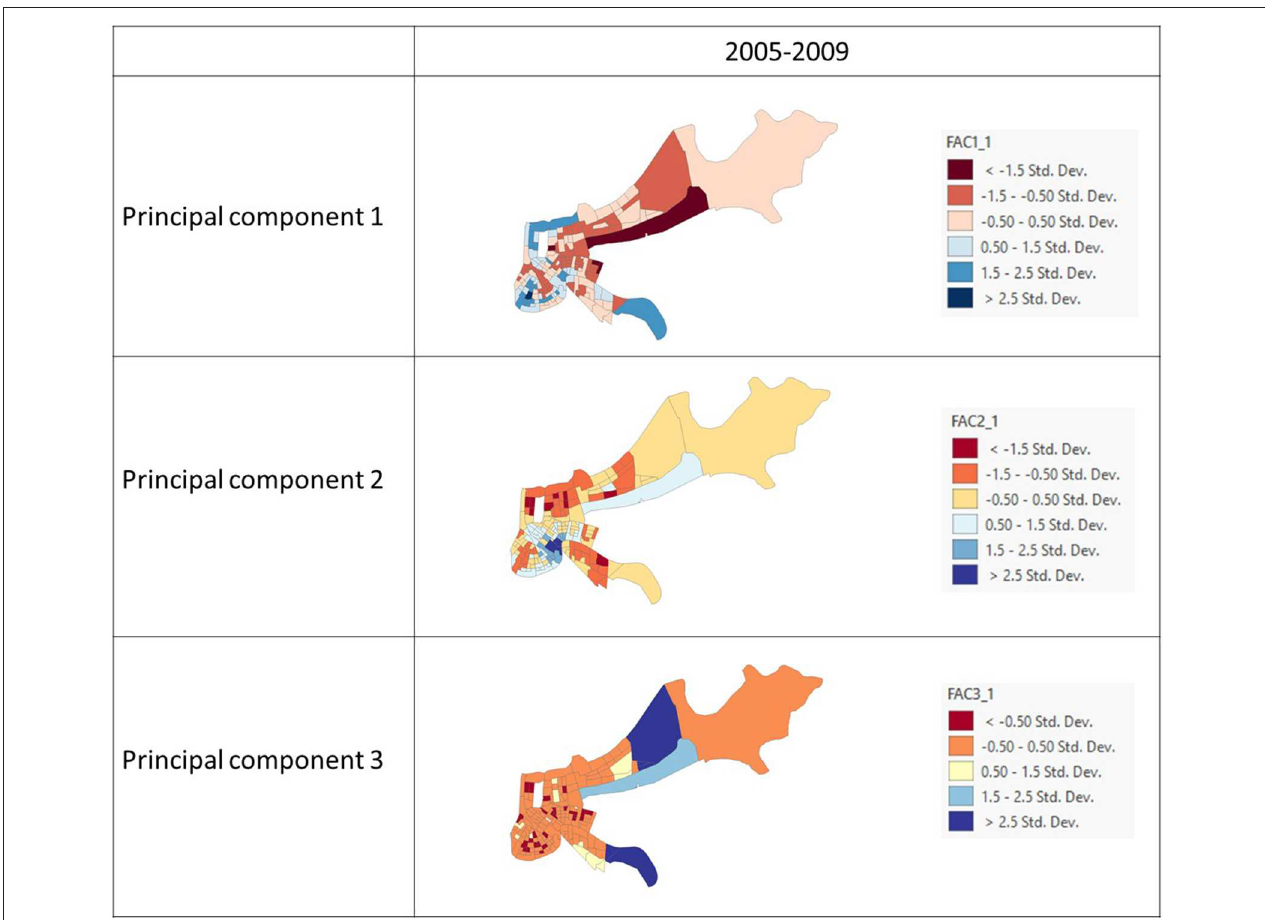
FIGURE 6 | First three principal components for 2005–2009. Classified by standard deviation.